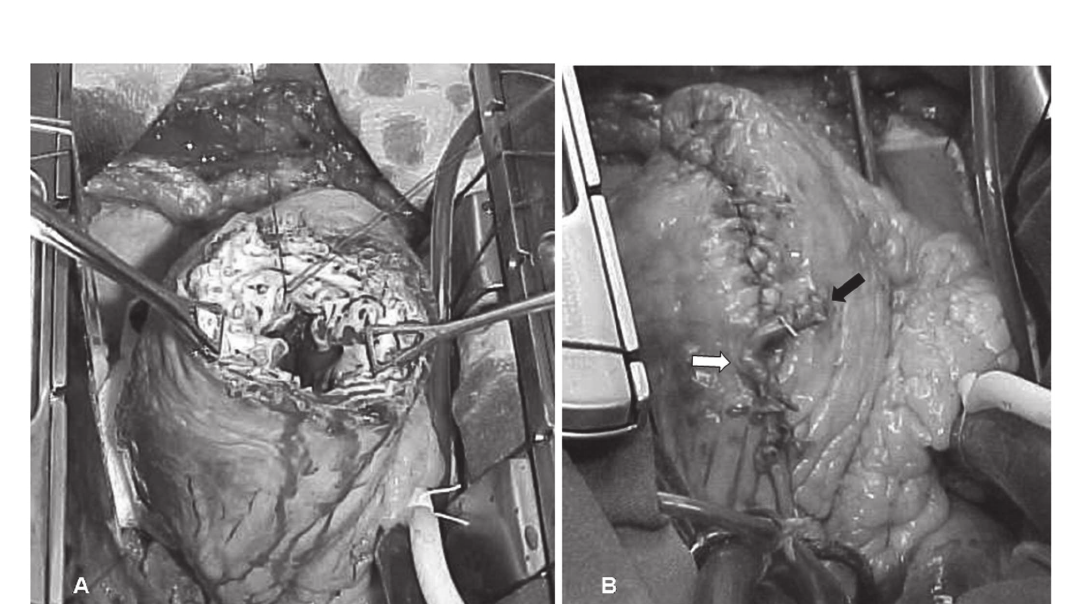
Fig. 2 - A. The left ventricle anterior wall sparingly incised at the aneurysmal area, parallel and at least 1.5 cm away from the interventricular septum and the left descending anterior coronary artery. B. Sequential LITA grafting to the left anterior descending coronary artery (black arrow) and a large diagonal branch (white arrow)